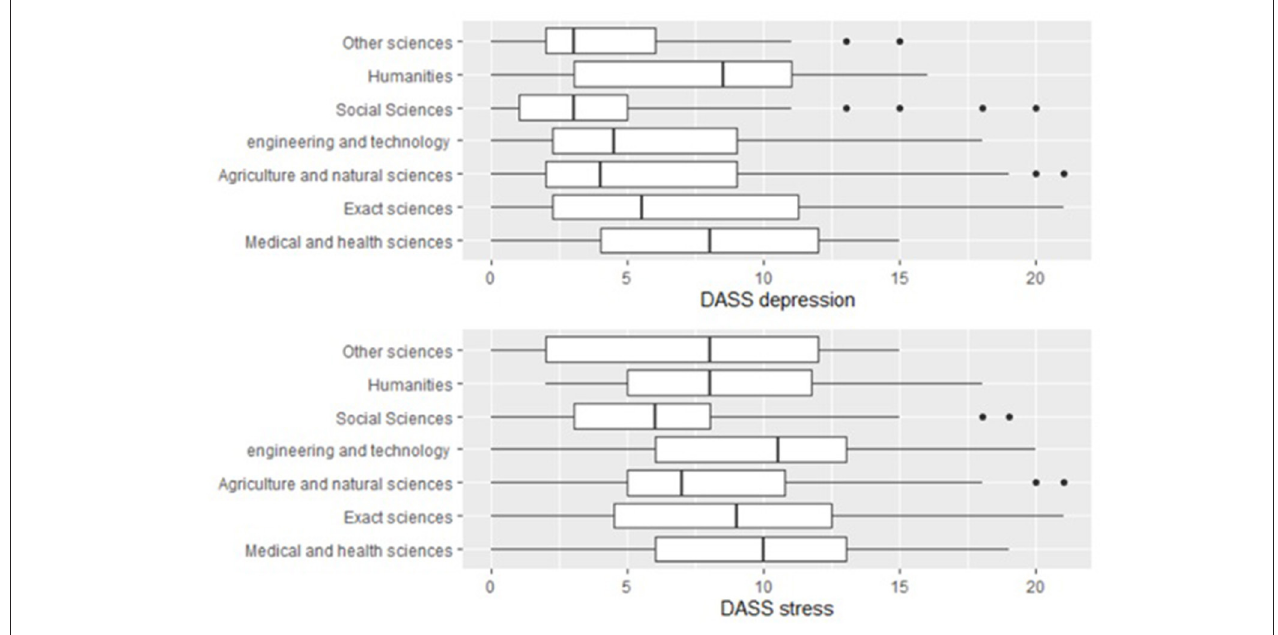
FIGURE 2 | Empirical distribution of DASS-21 depression and DASS-21 stress scales by research area of the researchers.